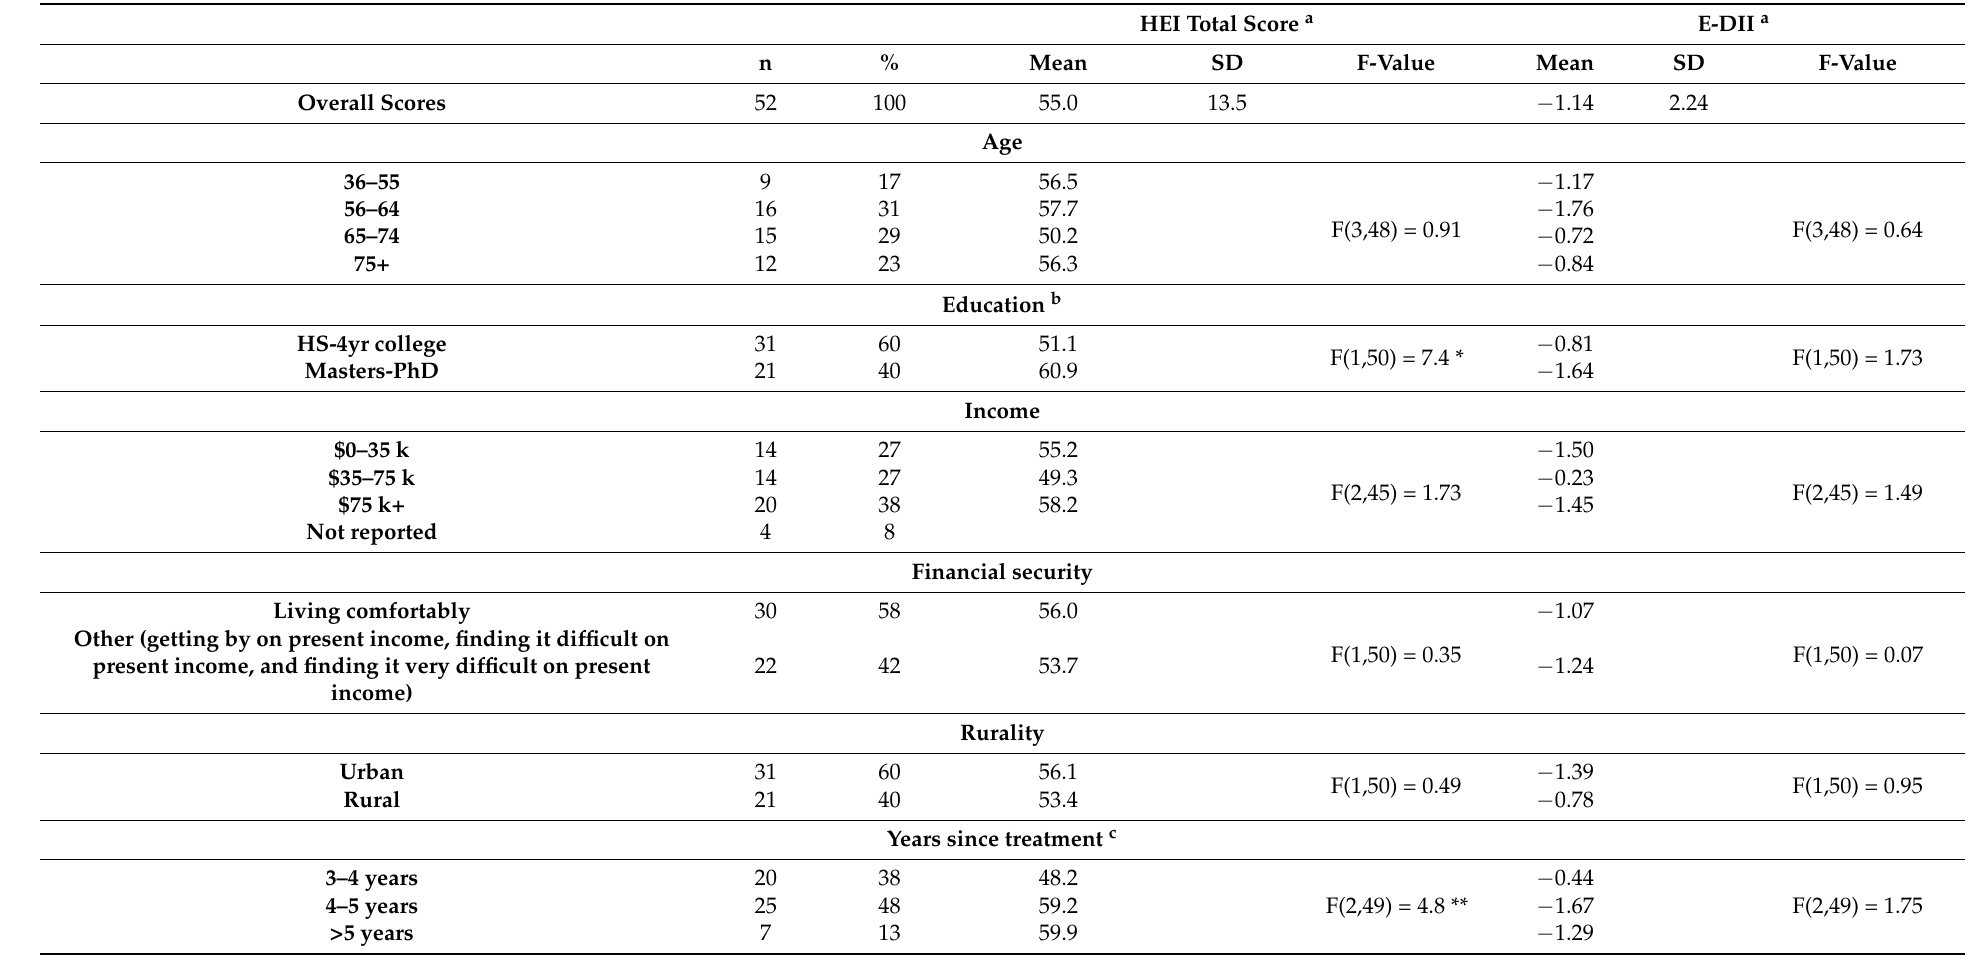
Table 2. Diet quality as measured by the Healthy Eating Index (HEI-2015) and Energy-adjusted Dietary Inflammatory Index (E-DII) scores among women’s cancer survivors, and differences by demographic characteristics (n